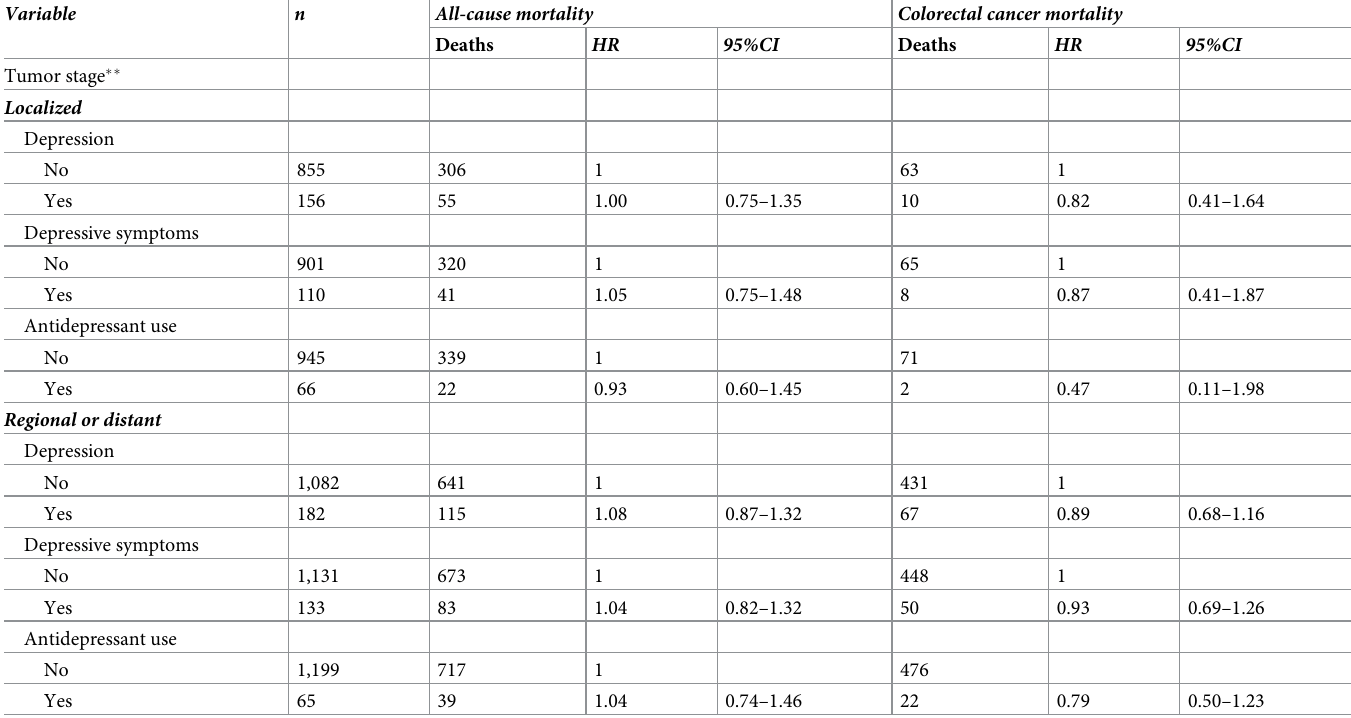
Table 3. Hazard ratios (HRs) and 95% confidence interval (CIs) for colorectal cancer outcome in relation to depression at WHI baseline stratified by tumor stage � .